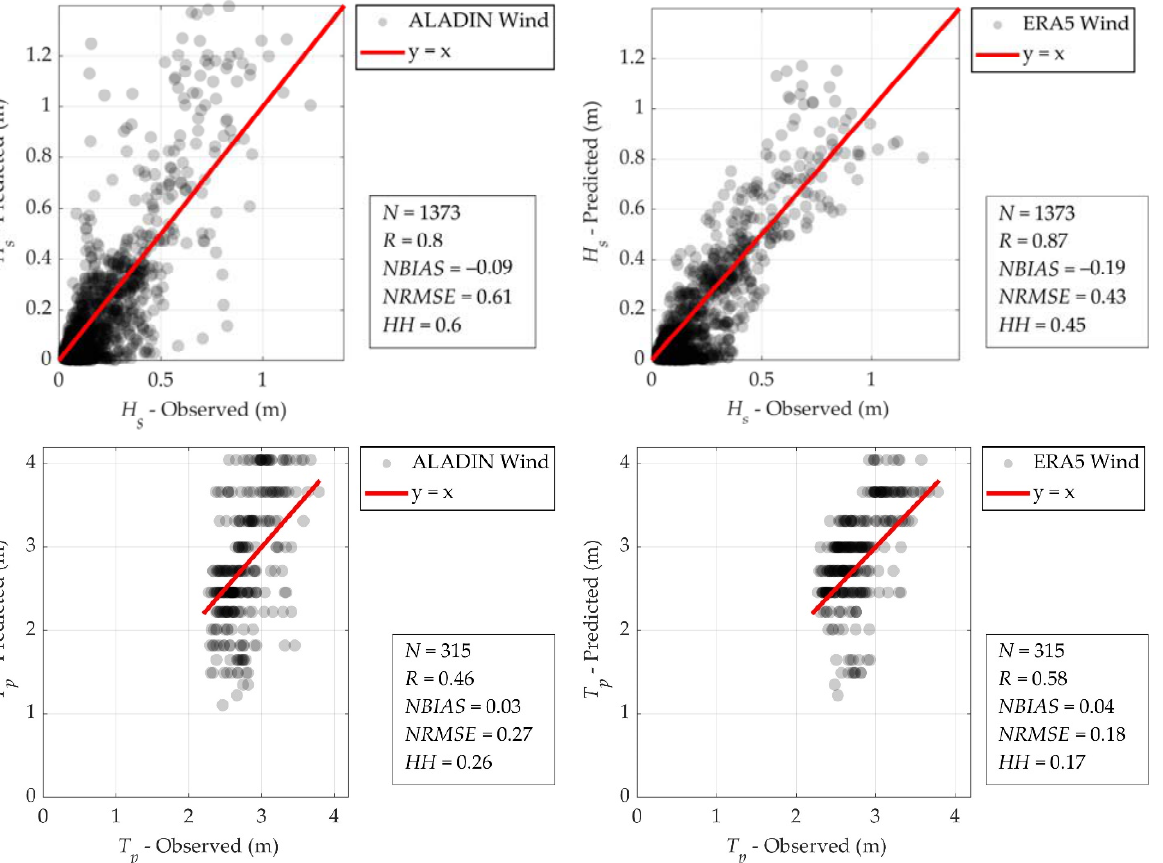
Figure 11. Scatter diagrams and performance metrics showing the consistency between the simulated significant wave heights (forced by ERA5 wind ( left ) with C ds = 1.2 and ALADIN ( right ) with C ds = 0.3) and measured significant wave heights and the consistency between the simulated peak wave periods and measured peak wave periods for the validation period